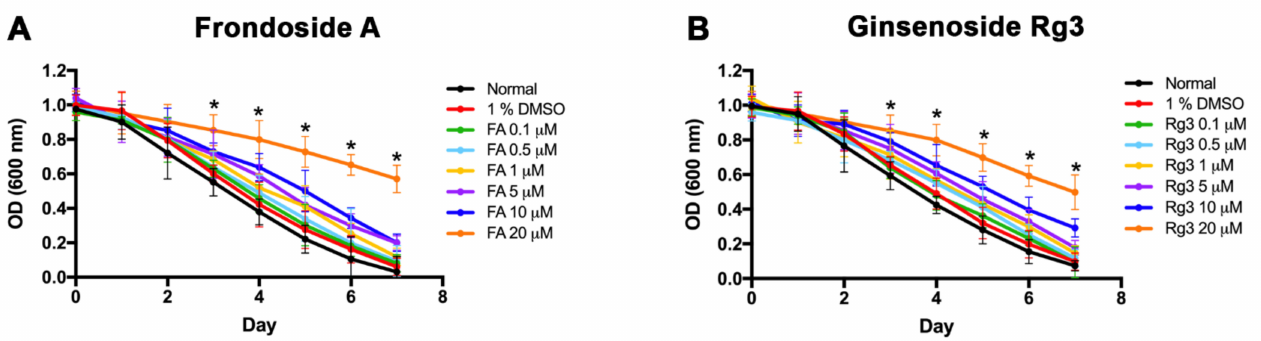
Figure 2. Food clearance assay of C. elegans treated with 0–20 µ M FA ( A ) and Rg3 ( B ). The asterisk (*) indicates a significant difference between the compound-treated worms compared with 1% DMSO-treated worms ( p < 0.01). The experiment was performed independently at least three times (number of worms = 30 animals/group per